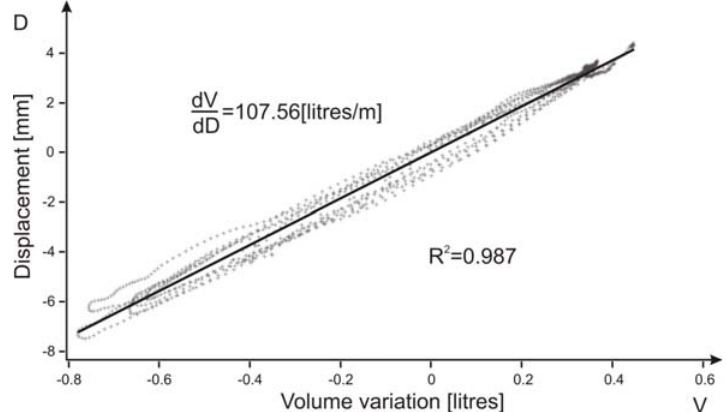
Figure 6. Displacements measured by the microwave sensor as a function of the volumes measured through the spirometer for one data set. Solid line represents the calculated linear regression.